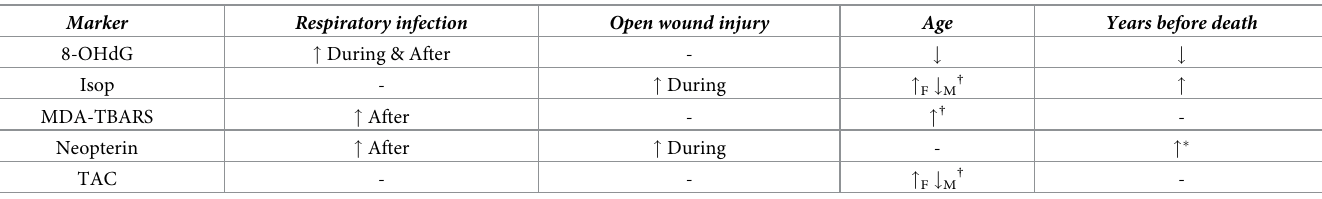
Table 4. Summary of